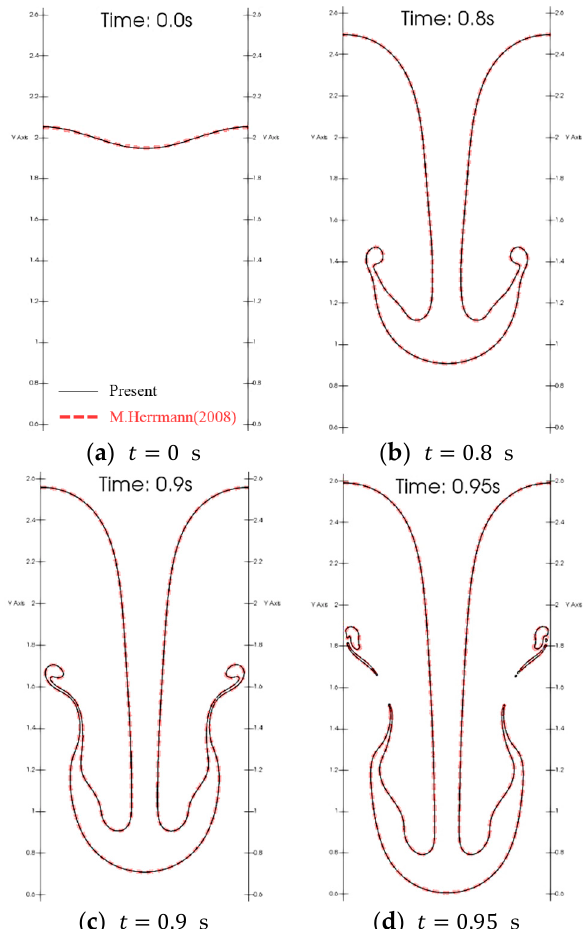
Figure 5. Rayleigh–Taylor instability with ℎ (cid:3008) = 1/256 grid